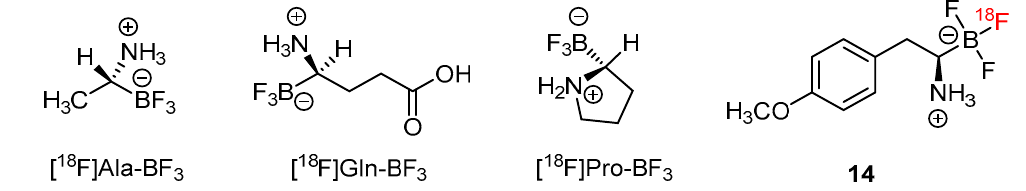
Figure 4. Radiofluoride-exchanging trifluoroborate-substituted amino acid analogs for tumor imag- ing [75]. A series of derivative [ 18 F]FBY analogs were developed for studying the uptake of radioactivity in tumors of B16-F10 xenograft mice [73]. Among them, the p -methoxy de- rivative 14 exerted a tumoral uptake of 3.5%ID/g (Figure 4). 1,3-Dipolar cycloaddition,